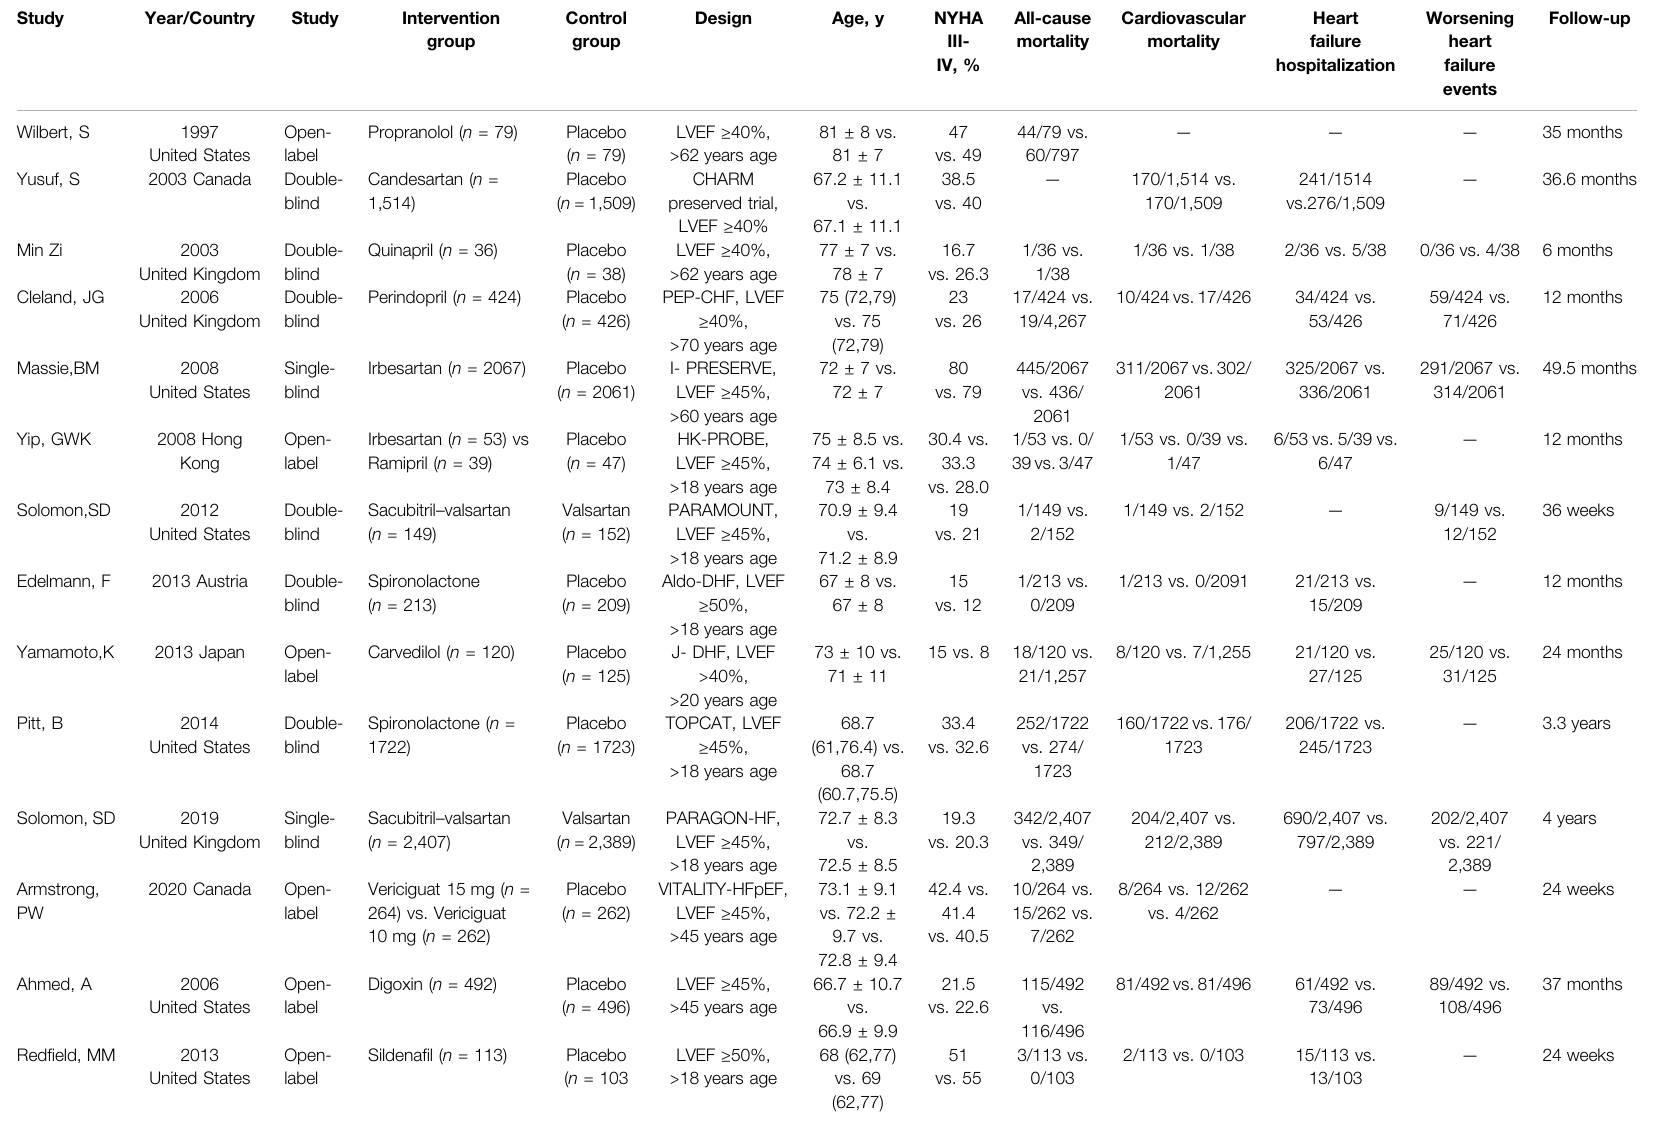
TABLE 1 | Baseline characteristics of included